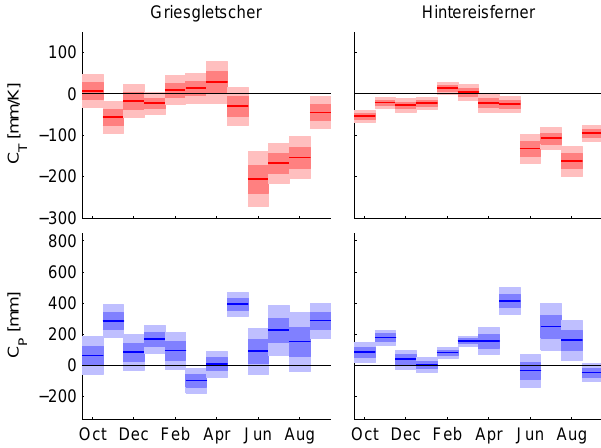
Fig. 7. Parameters of the SSC model as derived by multiple lin- ear regression for Griesgletscher (left) and Hintereisferner (right). (Light) shading indicates (double) standard deviations calculated from the cross